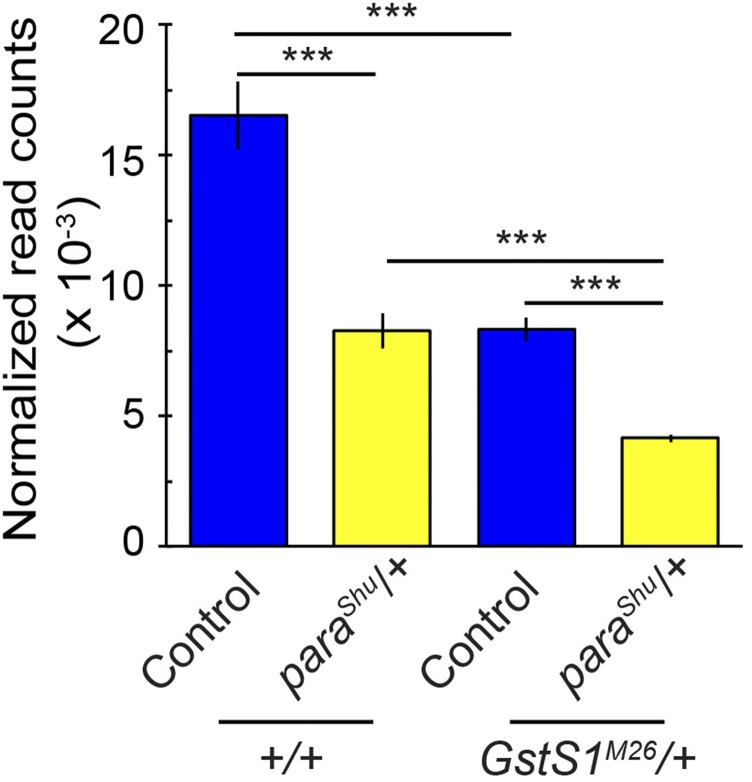
Reduction of GstS1 expression in paraShu. Levels of GstS1 transcript, as evaluated by RNAseq analysis in control (Canton-S) and paraShu heterozygous females with or without a GstS1M26 mutation (paraShu/+; +/+ or paraShu/+; GstS1M26/+) (see Materials and Methods). Averages of four biological replicates are shown, as normalized read counts with SEM and adjusted P-values (Padj). ***Padj < 0.001.